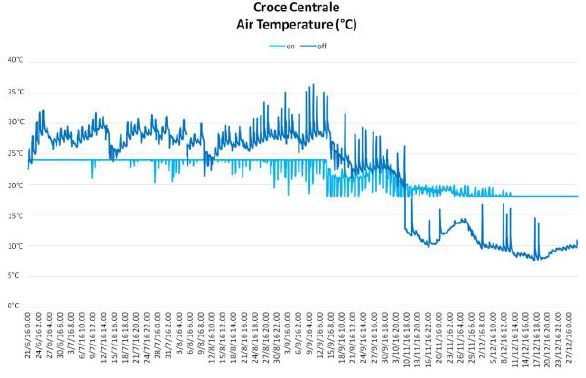
Figure 8. Air temperature trend in building simulation HVAC- ON and HVAC-OFF Scenarios, room “Croce Centrale”.